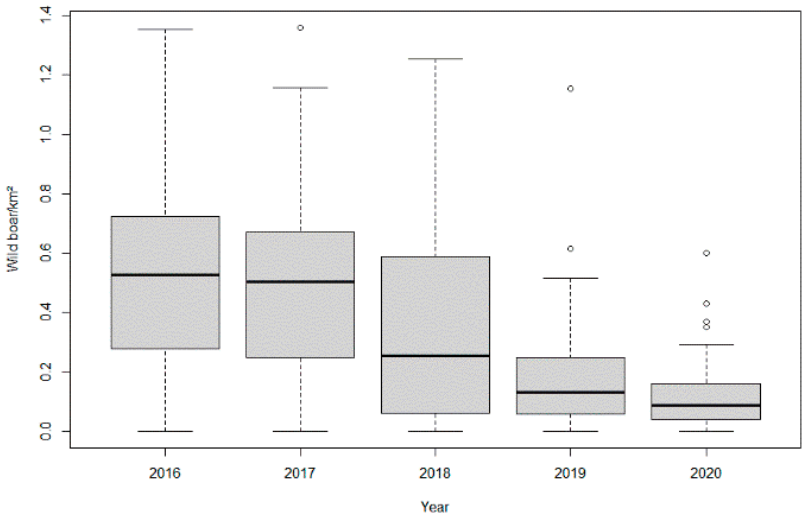
Figure 9. Estimated wild boar population density (wild boar/km²) based on hunting bag data per year. The horizontal lines that form the top of the boxes illustrate the 75th percentile. The horizontal line that forms the bottom indicate the 25th percentile. The horizontal lines that intersect the box represent the median number of wild boar per square kilometer. Whiskers indicate maximum and minimum values that are no more than 1.5 times the span of the interquartile range and the open circles represent outliers, which are single values greater or less than the extremes indicated by the whiskers.